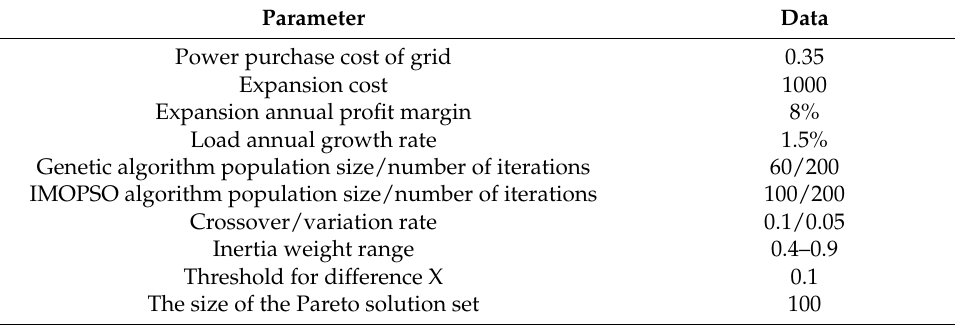
Table 4. Simulation parameter